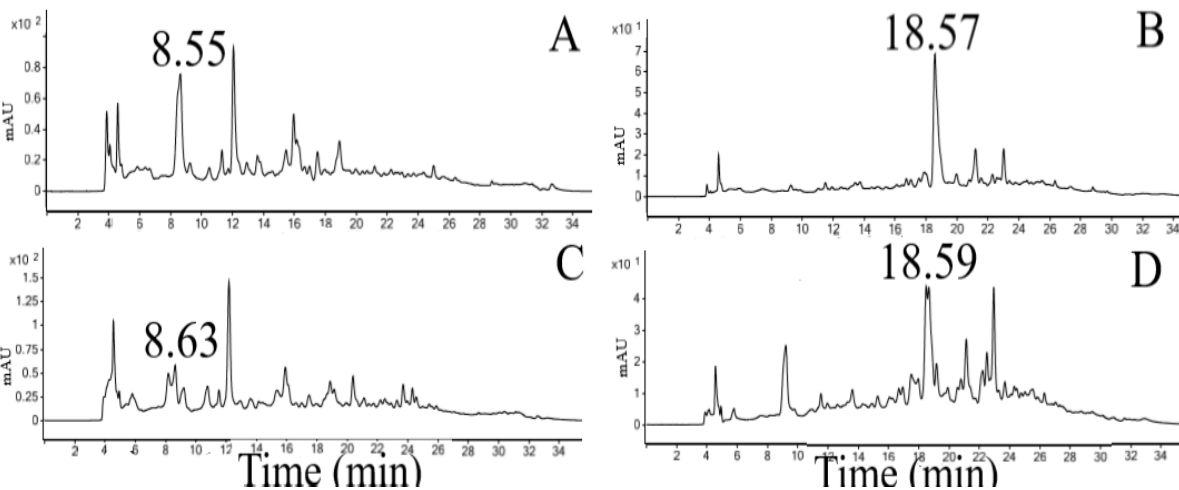
Figure 2. Chromatograms obtained for crude extract and microparticle after co-injection with the standard. ( A ) Peak gallic acid in crude extract (280 nm). ( B ) Peak caffeic acid in crude extract (325 nm). ( C ) Peak gallic acid in microparticle (280 nm). ( D ) Peak caffeic acid in microparticle (325 nm).